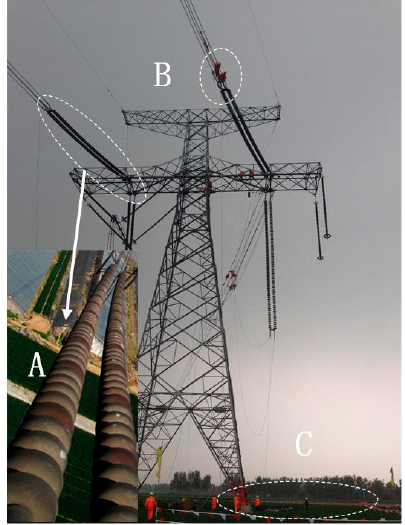
Figure 5. Sampling scene.